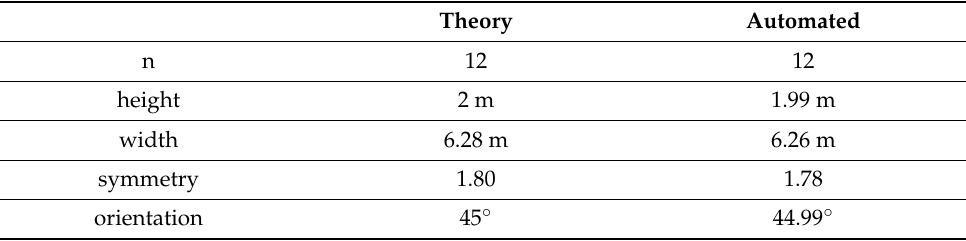
Figure 9. Illustration of the synthetic DEM and of the associated crestline polylines. Bedform metrics were then calculated using the generated crestline polylines as input. The analysis returned median values of 1.99 m, 6.26 m, 1.78 m and 44.99 degrees for the bedform height, width, symmetry index and orientation, respectively (Table 1). There is a good match between theoretical and computed values, which supports the validity of the concept. Table 1. Comparison of the theoretical and computed metrics.